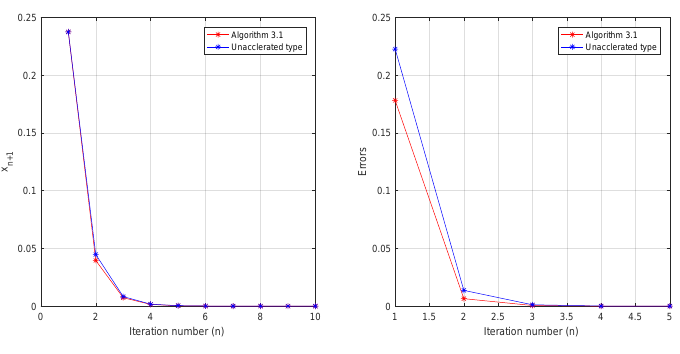
Algorithm 3.1 Unacclerated type